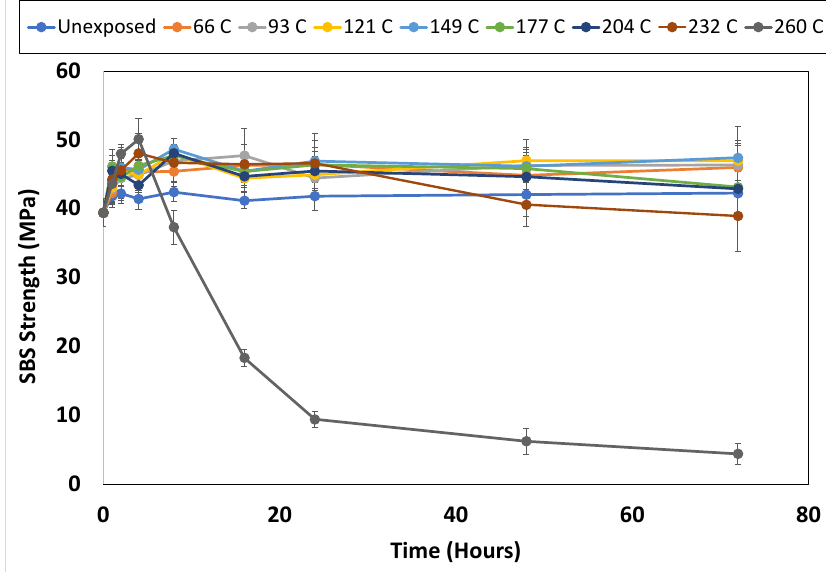
Figure 5. Residual SBS strength as a function of time and temperature of thermal aging.